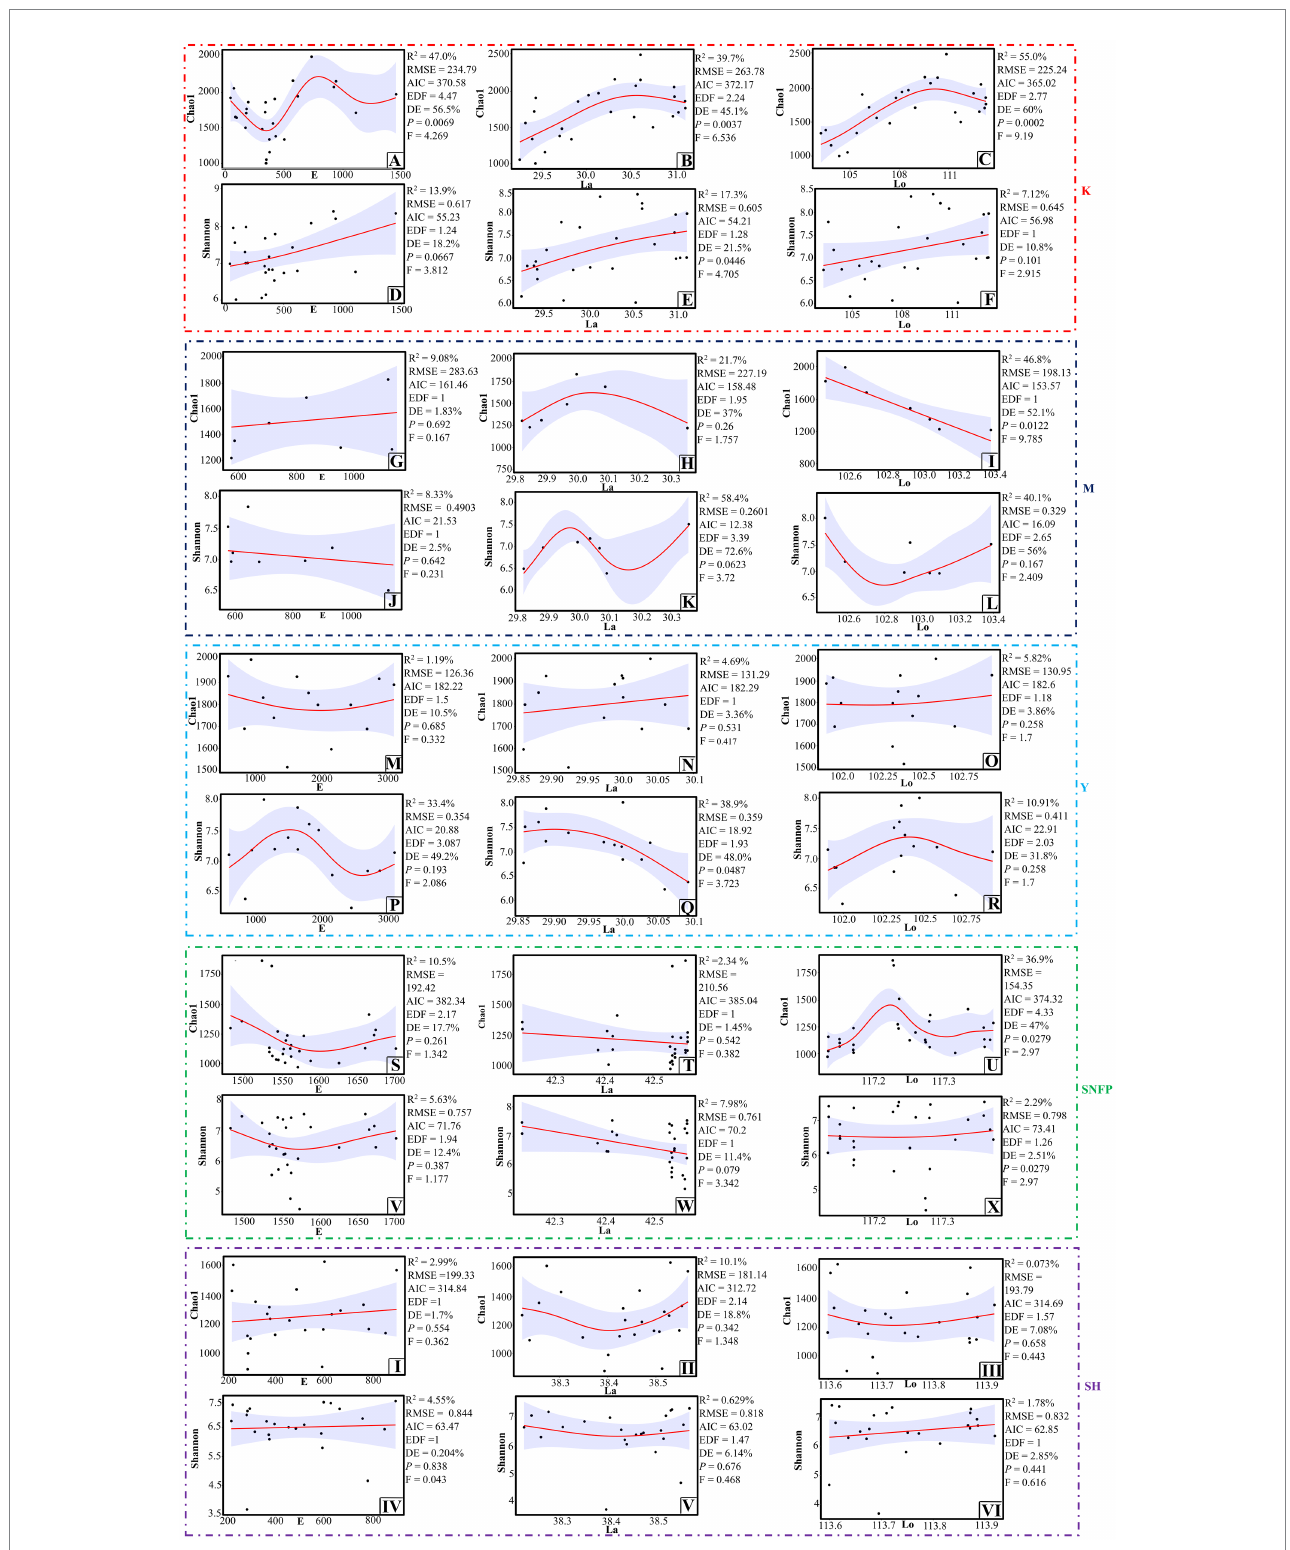
FIGURE 4 Test of the GAM analysis for detection of an association between fungal richness and diversity with geographical coordinates at the K sampling site (A–F) , at the M site (G–L) , at the Y sampling site (M–R) , at the SNFP site (S–X) , and the SH sampling site (I–VI) . 95% confidence interval is highlighted with the light violet color. Abbreviations of variables are given in Figure